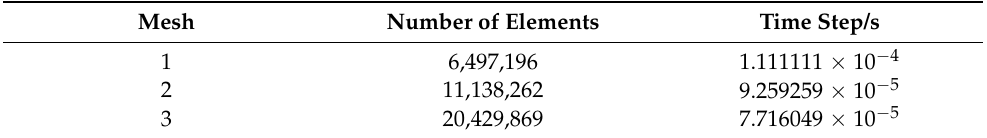
Table 1. Mesh information and time step